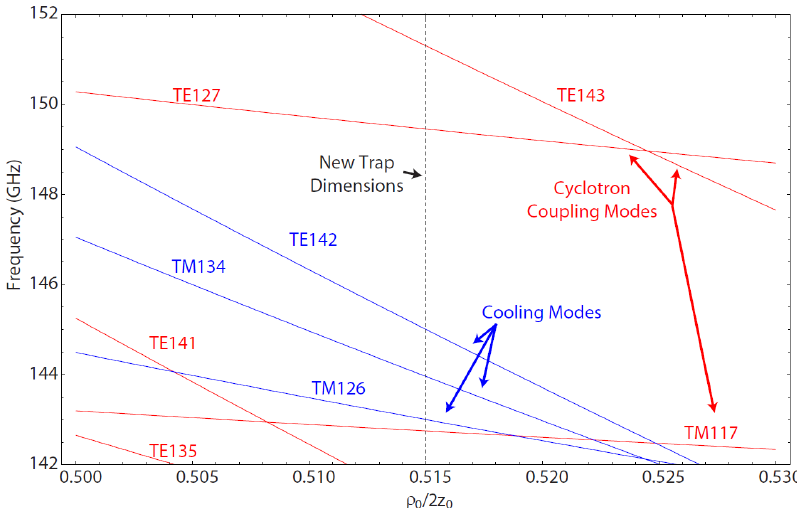
Figure 11. Calculated cavity mode structure for the current cylindrical trap cavity of radius ρ 0 and length z 0